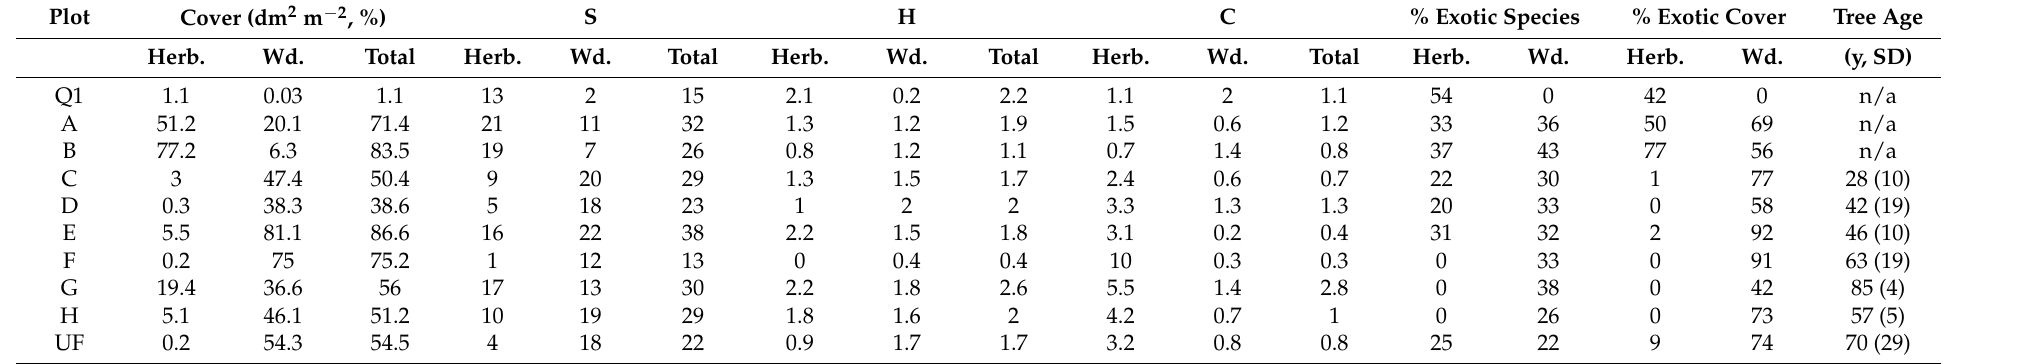
Table 1. Vegetation characteristics in eight plots of a 70-year-old abandoned quarry (Plots A–E: quarry floor, F–H: quarry top), one plot of a recently decommissioned reference quarry (Q1), and in one plot in an urban forest reference site (UF). Study sites are located in Jefferson City, MO, USA. Herbaceous (Herb.) vegetation was recorded at ≤ 1 m height; woody (Wd.) vegetation was recorded at 0–2 m height. S—species richness, H—Shannon-Wiener Diversity index, J—Pielou’s evenness, and C —Coefficient of Conservatism are based on the 20-m 2 of sampled plot